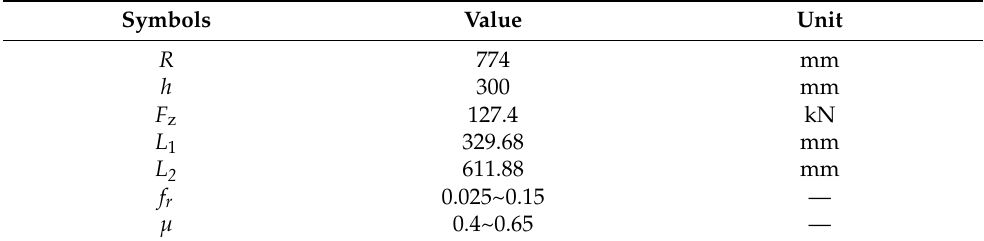
Table 1. Parameters of the